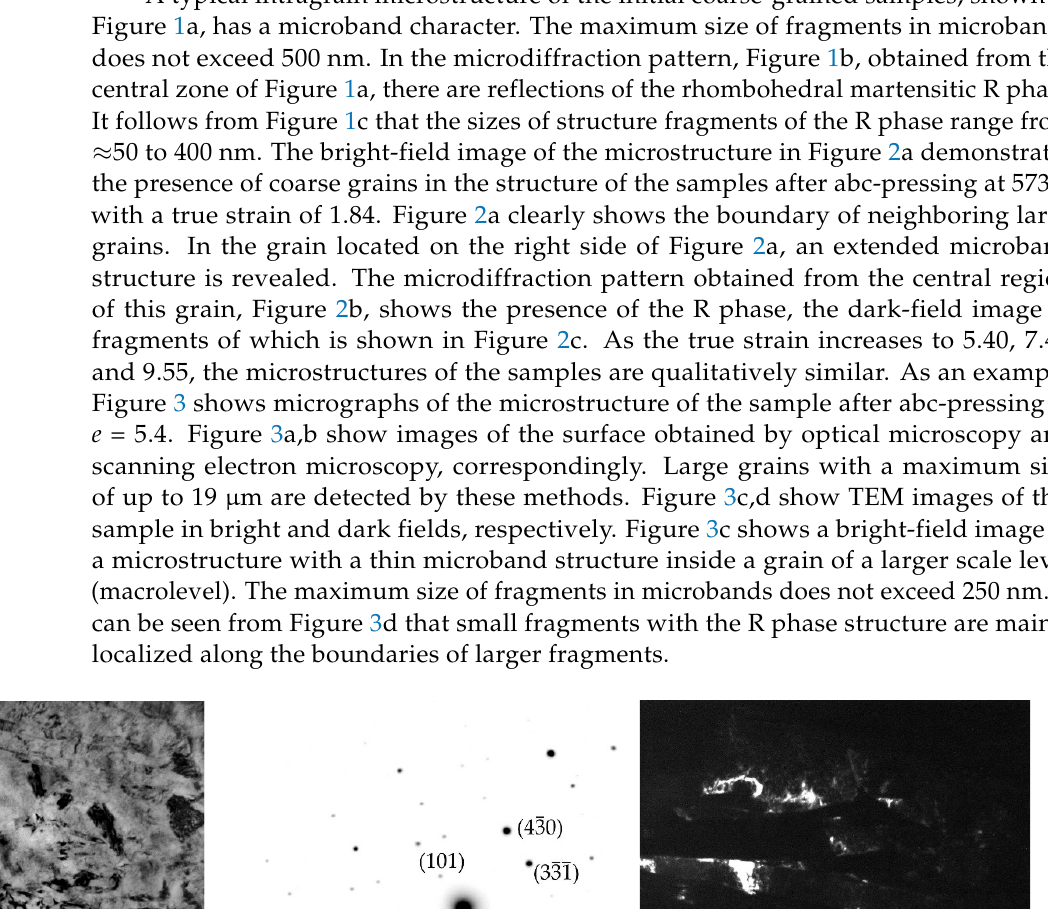
(cid:0) (cid:1) 430 R phase reflection ( c